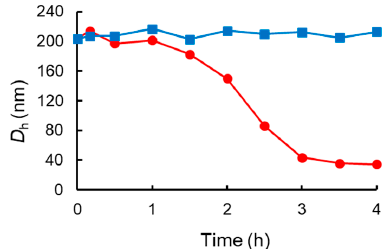
Figure 2. Time course of the Z-average of the hydrodynamic diameter ( D h ) for the EI 4 /Gal-Dex- g -SS- OLA nanogel monitored by dynamic light scattering (DLS) in the presence (red circles) or absence (blue squares) of 10 mM glutathione (GSH) in phosphate buffer (PB) solution.